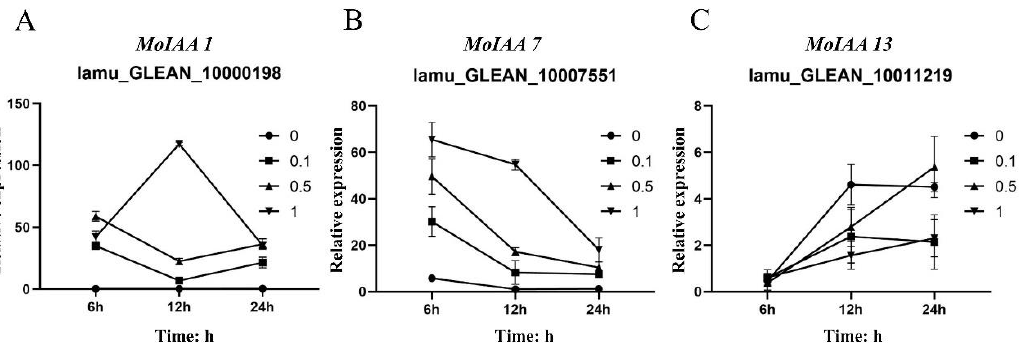
Figure 7. Relative expression level of MoIAA1 ( A ), MoIAA7 ( B ) and MoIAA13 ( C ) under NAA treatment at 6, 12, and 24 h. The expression value was calculated relative to 0 h.